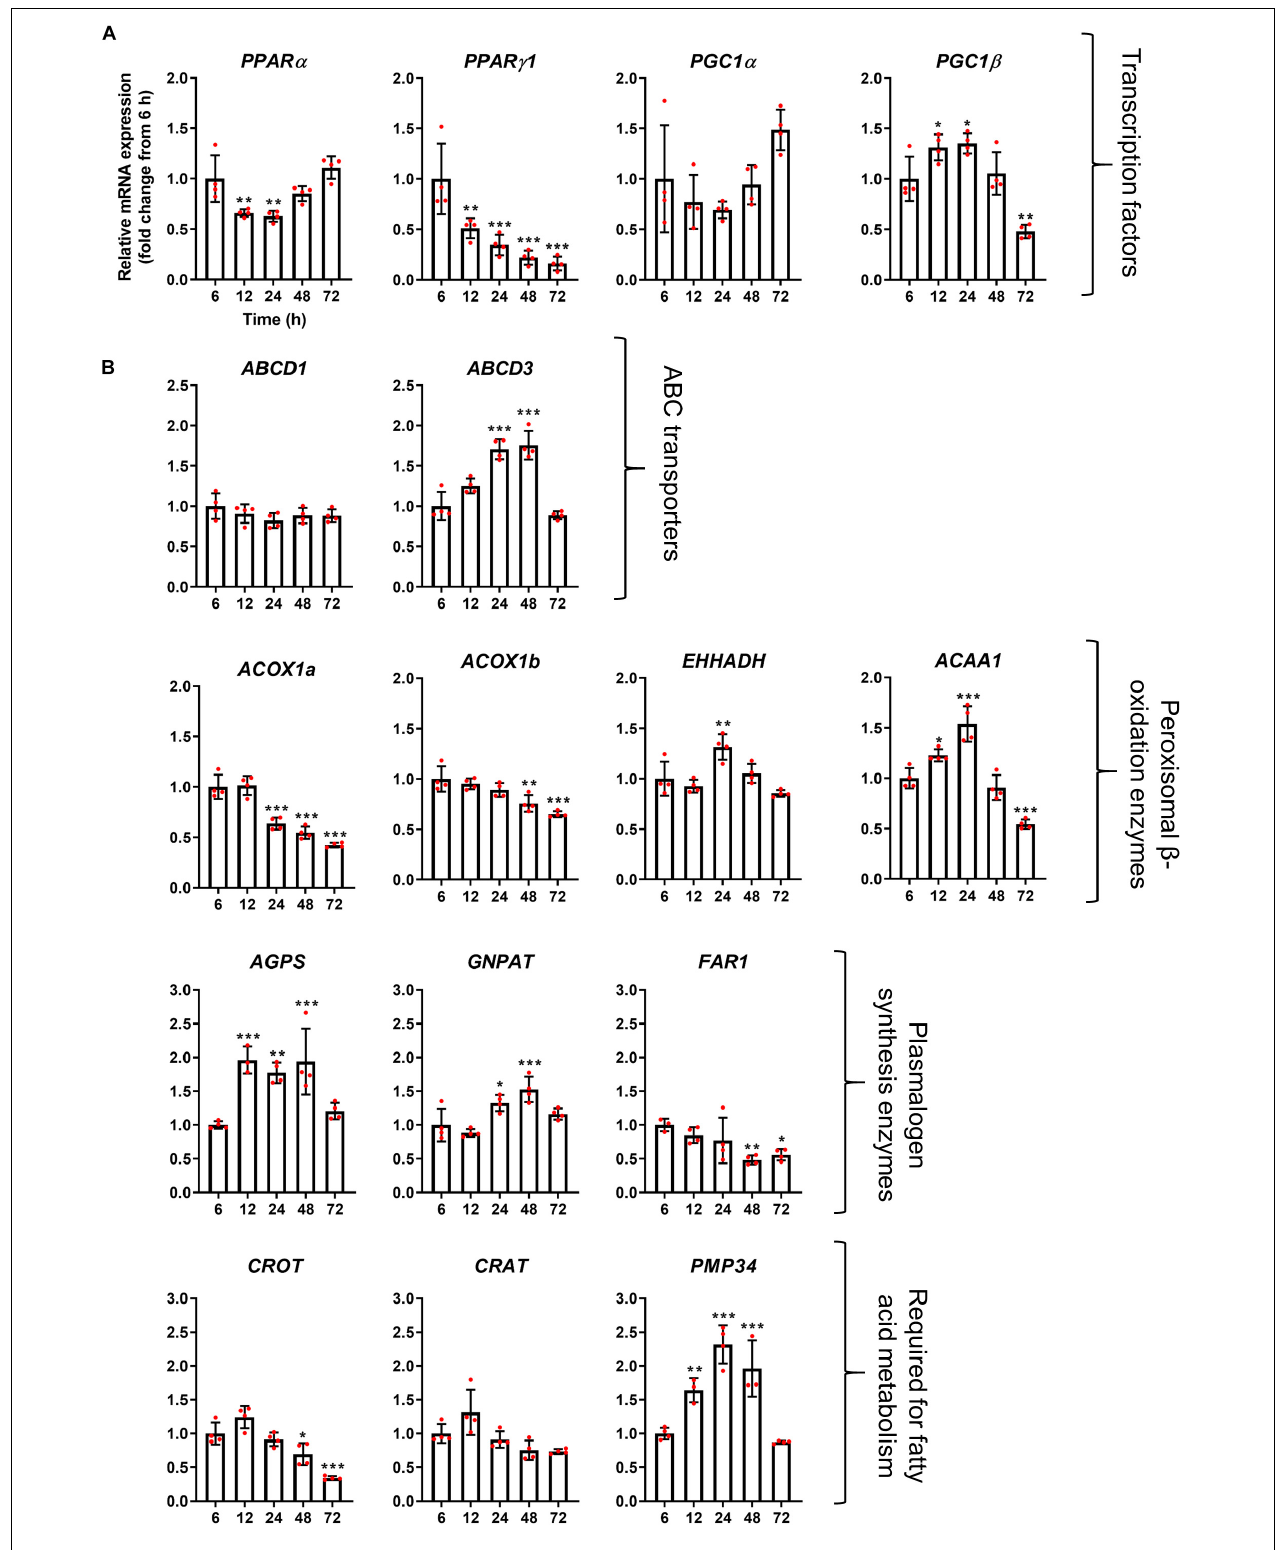
FIGURE 4 | mRNA abundance profiles of peroxisomal transcription factors/co-factors (A) and peroxisomal genes associated with fatty acid beta-oxidation (B) in HepG2 cells during a time course. qPCR analysis of relative mRNA levels of the indicated genes, normalized to 18S rRNA expression over time. Data from 4 independent experiments; analyzed by one-way ANOVA with Dunnett’s post hoc test; * p < 0.05, ** p < 0.01, *** p < 0.001.